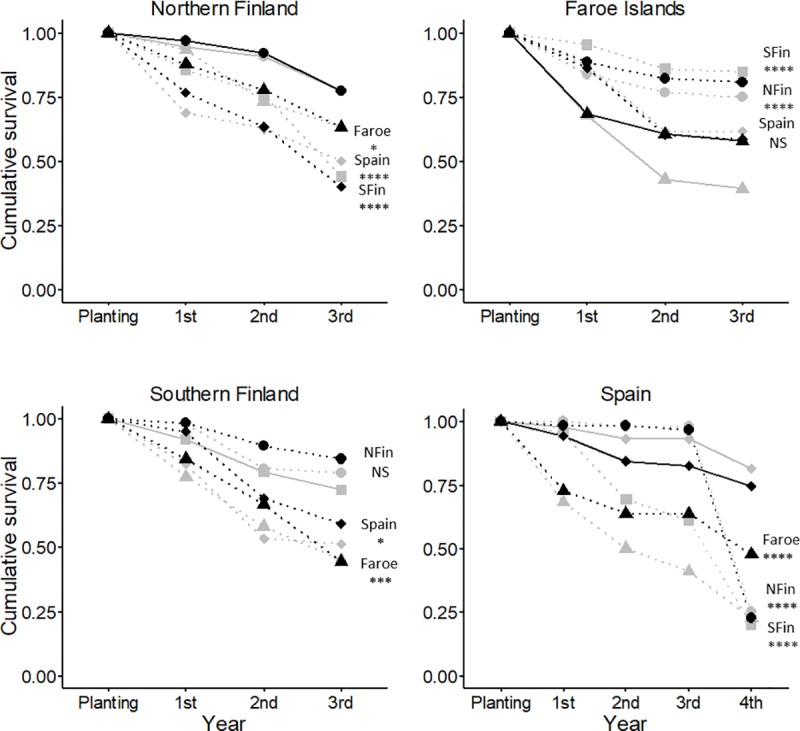
Survival in the field.Cumulative survival of the host plant Festuca rubra originating from four geographic regions (circles: northern Finland, triangles: Faroe Islands, squares: southern Finland, diamonds: Spain) for plants with (black) and without (grey) fungal symbiont Epichloë festucae in a four-way reciprocal transplant experiment in their local environments in northern Finland, Faroe Islands, southern Finland and Spain. Local geographic origin at each site is indicated with a solid line. Asterisks indicate significance of likelihood ratio tests for survival at the end of the experiment between local and nonlocal genotypes (**** P < 0.0001; *** P < 0.001; ** P < 0.01; * P < 0.05; NS P > 0.05). See Table 3 for full details of results of the statistical tests.